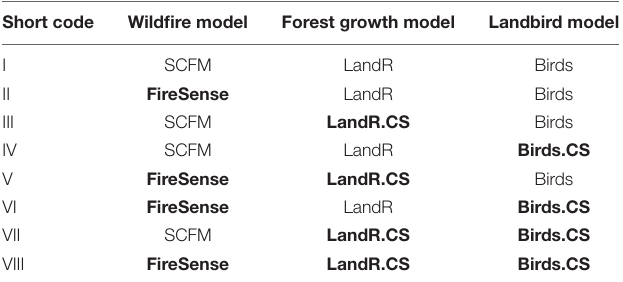
TABLE 2 | Wildfire, forest growth and landbird models used in a factorial simulation experiment to explore the pathways through which climate change might drive responses and forecast the net effect of climate change on different boreal landbird